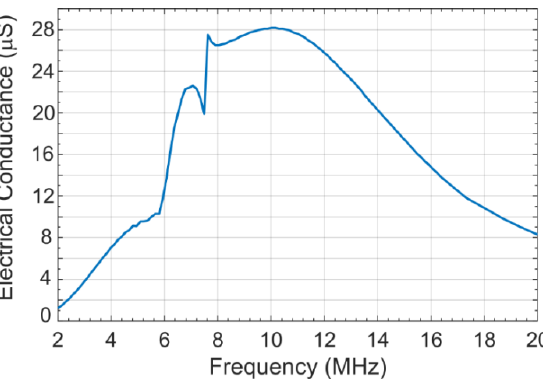
Figure 5. Frequency response of the excited CMUT array element without silica aerogel coating [21].